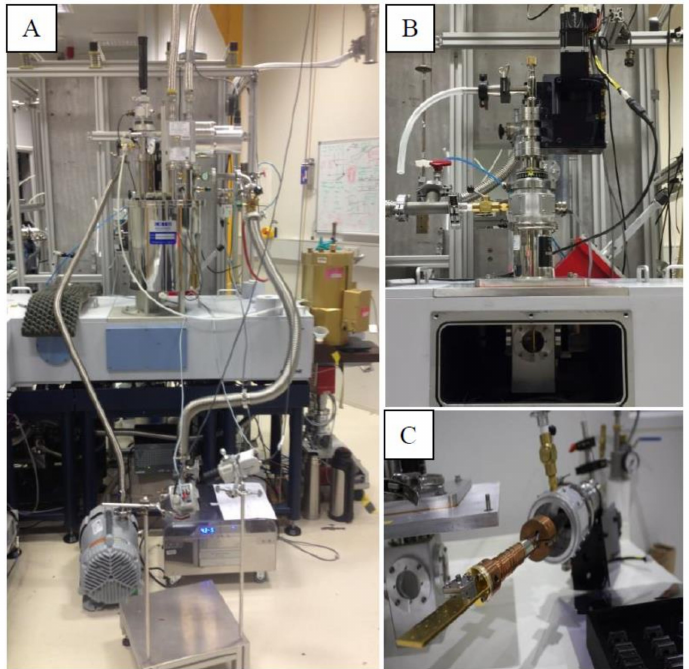
Figure 8. Experimental set up of THz exposure. ( A ) Closed-loop pulse tube cryostat containing the DLC and the ( B ) liquid nitrogen cryostat. ( C ) Sample holder onto which the DLC are mounted on for